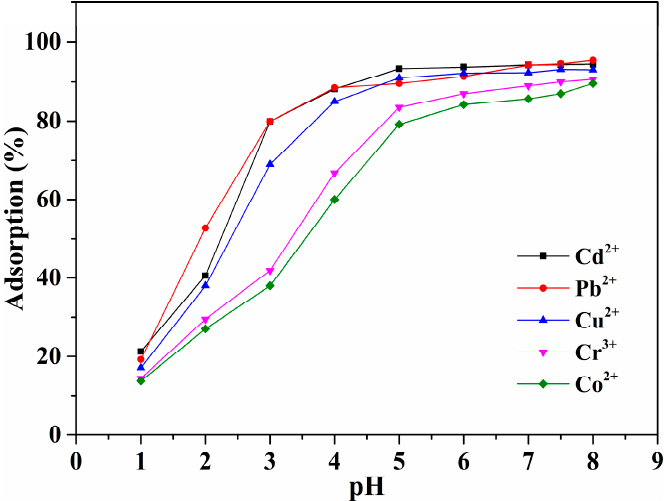
Figure 5. Effect of solution pH on metal ion adsorption of the Alg-EDTA.